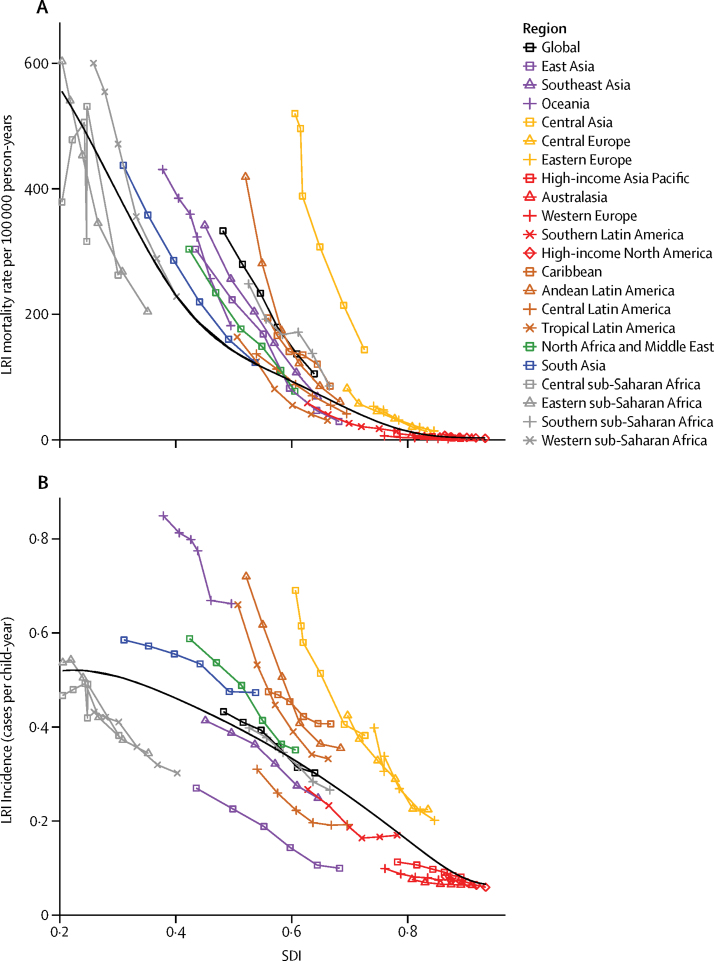
LRI burden by Global Burden of Diseases Study region plotted against SDIUnder-5 LRI mortality rate per 100 000 (A) and incidence per child-year (B) is shown. Data points show 5-year increments from 1990 to 2015. The black line is a least-squares cubic spline regression, with knots at 0·4, 0·6, and 0·8, using the under-5 LRI mortality rate or incidence for each geographic location, and represents the expected rate based on SDI alone (estimates above the black line are higher than expected and those below are lower than expected). More information on the formulation and theory of the SDI can be found in the Cause of Death GBD 2015 capstone paper.5 LRI=lower respiratory tract infection. SDI=Sociodemographic Index.